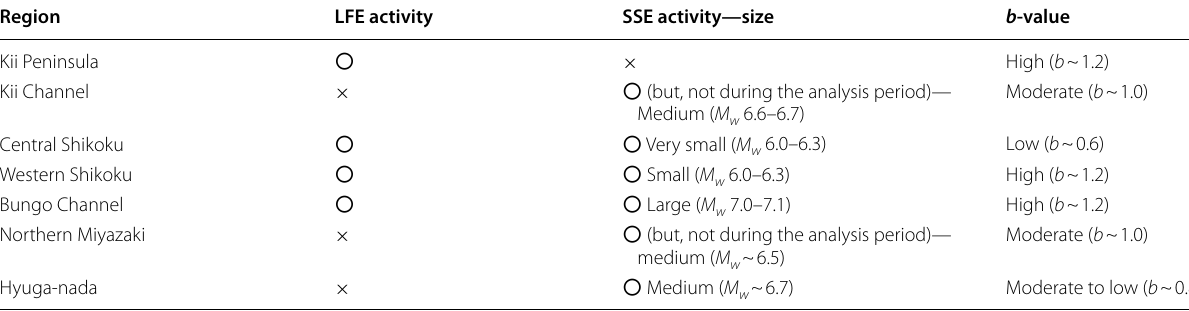
The magnitude size of the SSEs is based on the following studies: (1) Kii Channel (Kobayashi 2014; Geospatial Information Authority of Japan 2016); (2) west to central Shikoku (Takagi et al. 2016); (3) Bungo Channel (Ozawa et al. 2013; Ozawa 2017); (4) northern Miyazaki (Ozawa et al. 2001); and (5) Hyuga-nada regions (Yarai and Ozawa 2013)